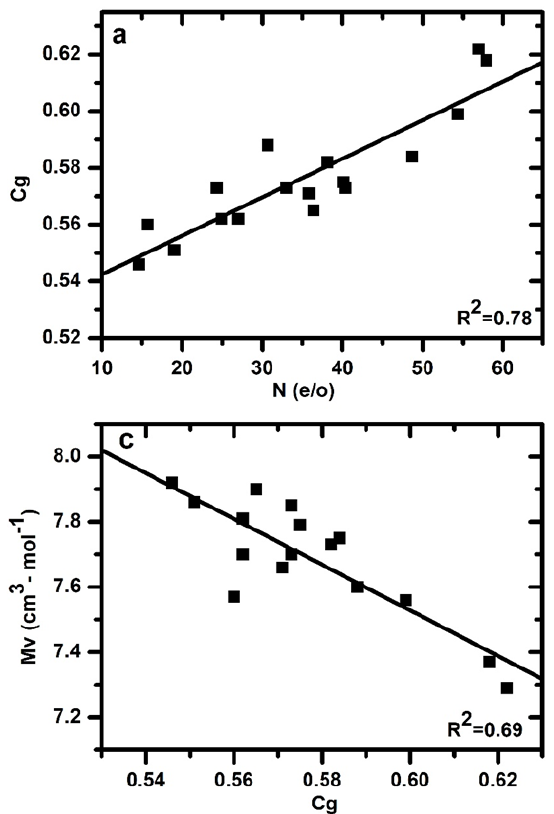
Figure 2. ( a ) Relation between glass atomic packing density and nitrogen content ( b ) glass density